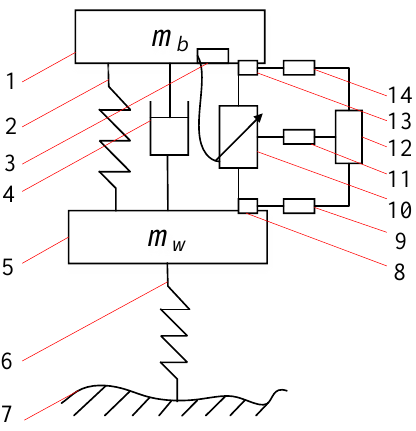
Figure 4. Structural drawing of energy regenerative active suspension. 1. Body 2. Damping spring 3. Storage/energy supply module 4. Suspension damping 5. Wheel 6. Tire equivalent spring 7. Road 8/13. Sensor 9/14. DAC 10. Ball screw type shock absorber 11 ADC 12.